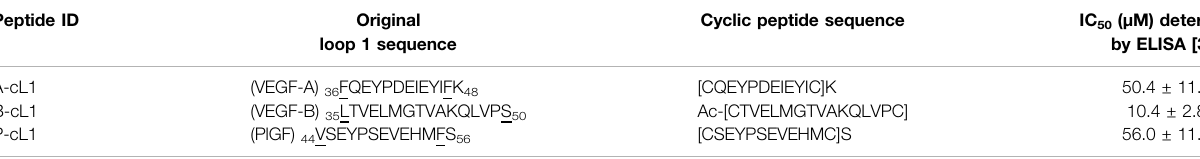
TABLE 1 | Peptide ID, original Loop 1 sequence and derived cyclic peptide sequence. IC 50 were determined in an ELISA based on the VEGF-A/VEGFR1 interaction.